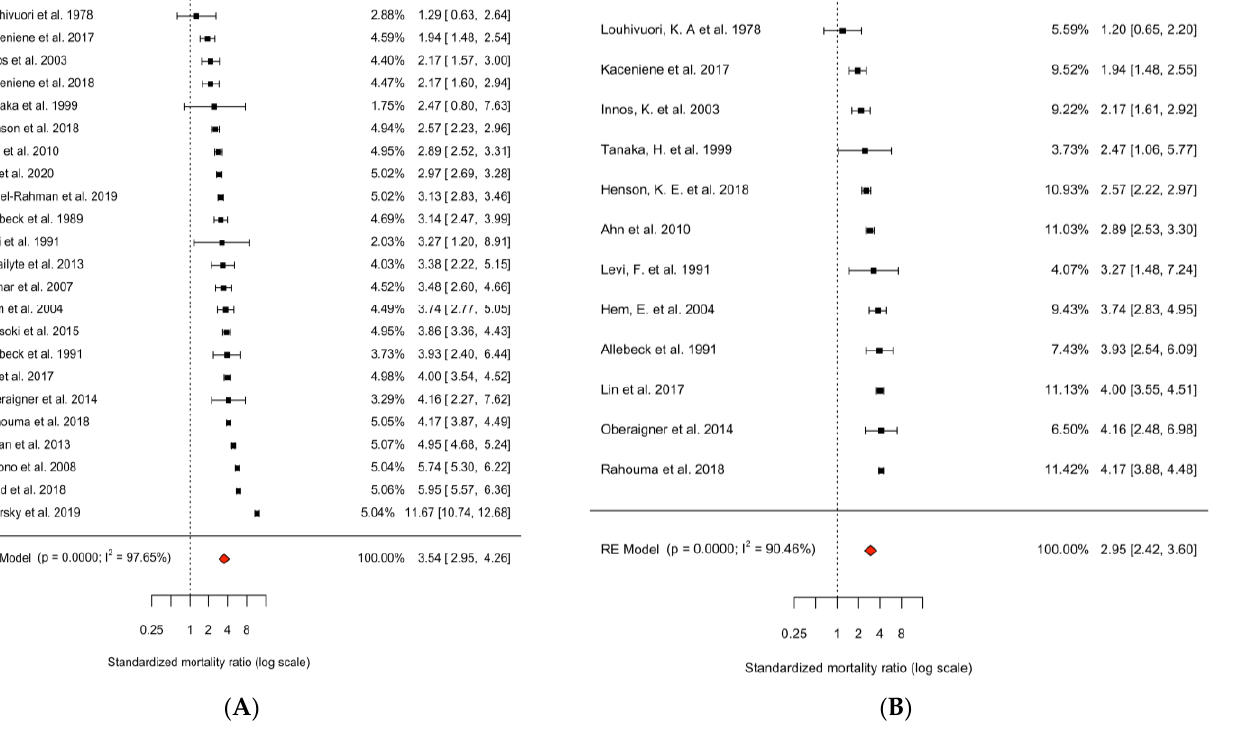
( B ) Figure 4. Summary forest plot of subgroup analyses of suicide in patients with lung-cancer. ( A ) All 23 studies sorted by risk estimate. I 2 = 85.70%, P-heterogeneity = 0.0000. ( B ) 12 studies sorted by risk estimate. I 2 = 90.29%, P-heterogeneity = 0.0000. Abbreviations: SMR, standardized mortality ratio; CI, confidence interval; n, number of studies included in the analysis. 3.3. Subgroup Analyses After exclusion of studies with potential patient overlap, the risk of suicide according to time after diagnosis was analyzed, showing a significantly higher ( p -value < 0.001) su- icide risk within one year after diagnosis (SMR = 5.00, 95% CI = 4.11 – 6.08) as compared to more than one year after diagnosis (SMR = 1.52, 95% CI = 1.21 – 1.91). In further subgroup analyses, no statistically significant differences in suicide risk were observed (Figure 4B and Appendix B, Table 1). In all nine studies that stratified by gender, both men and women with lung cancer showed an elevated SMR for suicide com- pared to the general population (SMR for women = 3.32, 95% CI = 2.92 – 3.78; SMR for men